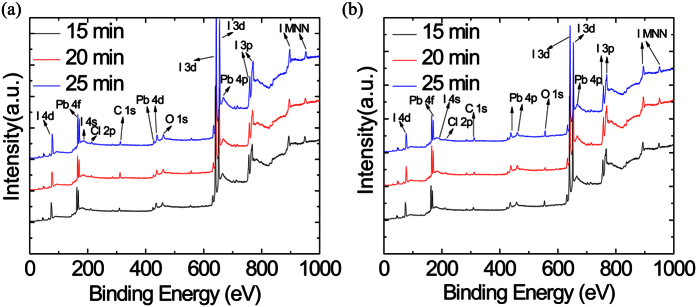
XPS spectra of MAxFA1−xPbI3 films with (a) 10, and (b) 400 sccm H2 flow rates with growth time increasing from 15 to 25 min.